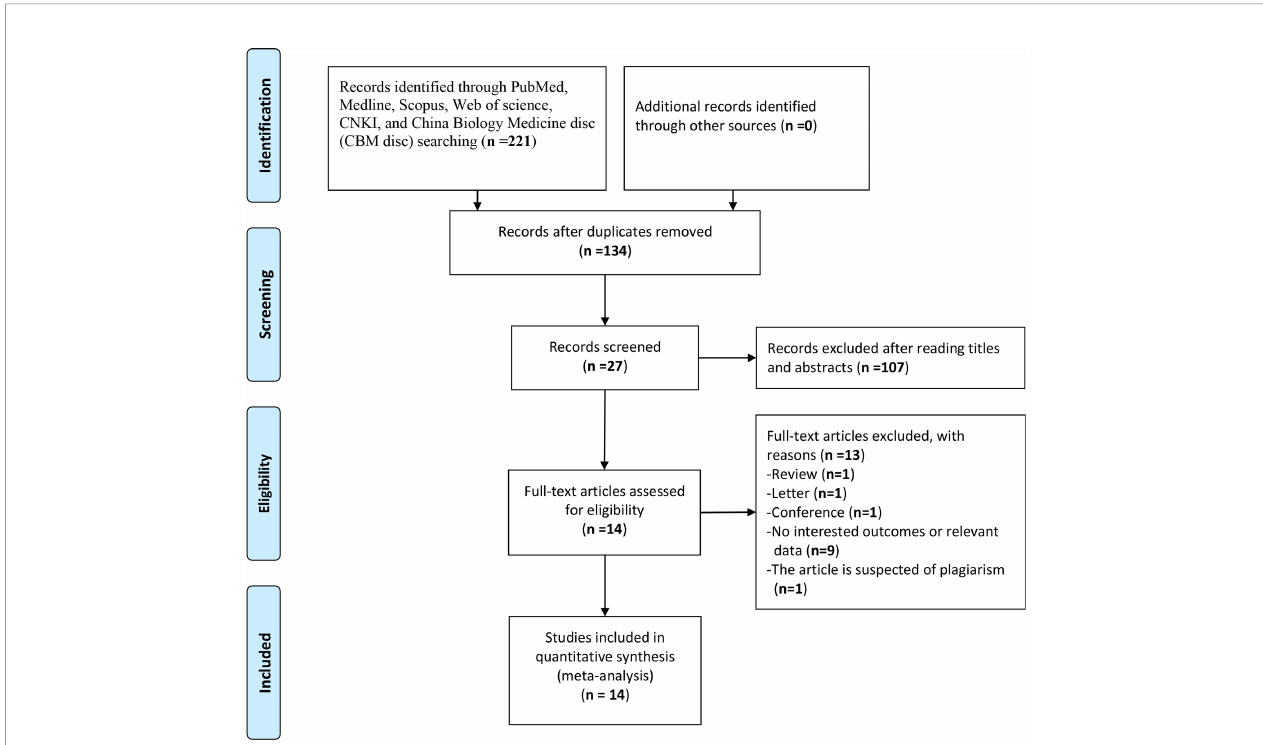
FIGURE 1 | Flow diagram following the PRISMA template of the search strategy for studies included in this